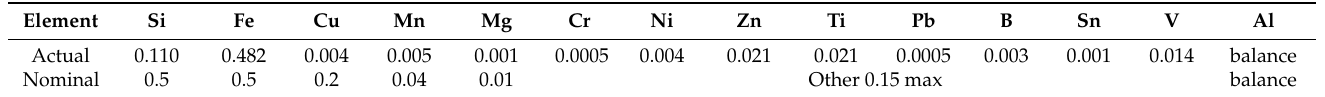
Table 2. Chemical composition of the AA1100 aluminium alloy sheet (in wt.%).